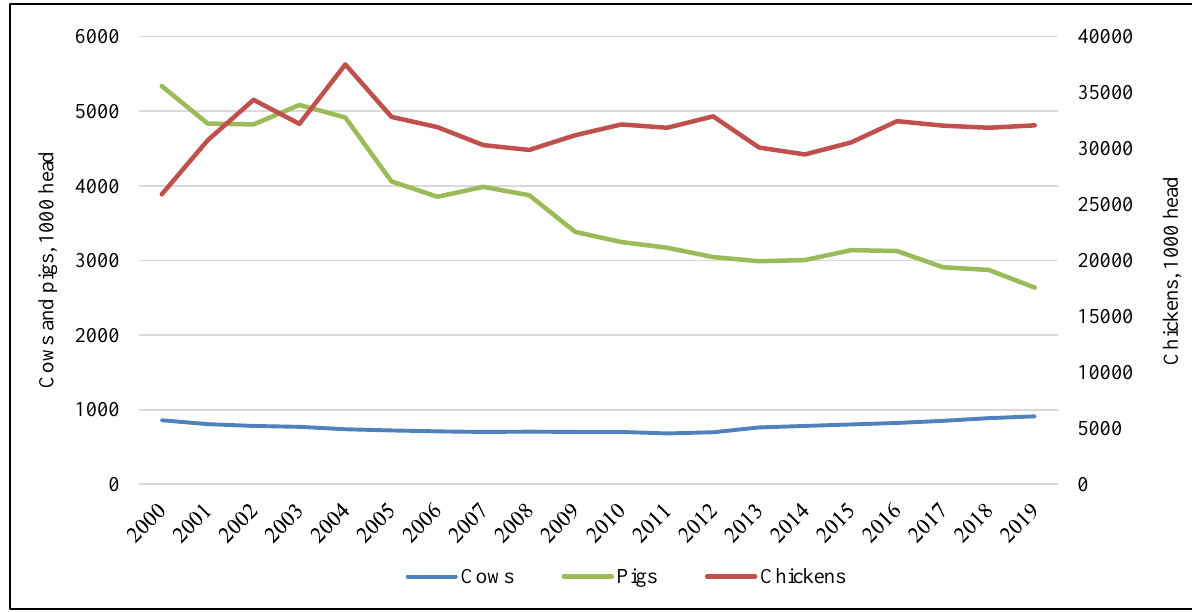
Figure 4. Amount of the three major livestock types; Source: Author’s composition based on FAO